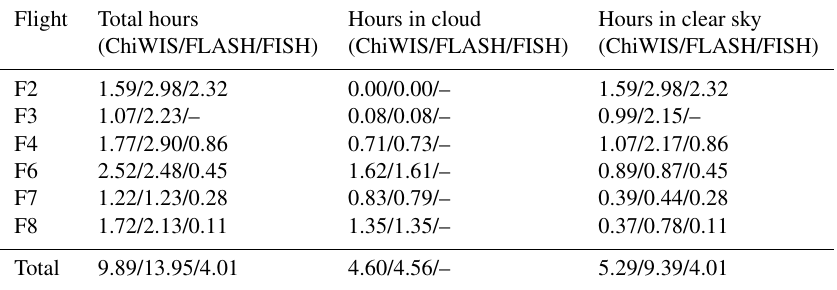
Table 2. Summary of total hours measured on each flight in UTLS conditions ( < 10ppmv). Hours included in the intercomparison (as described in Sect. 2.7) are reported in total, in cloud, and in clear sky for each